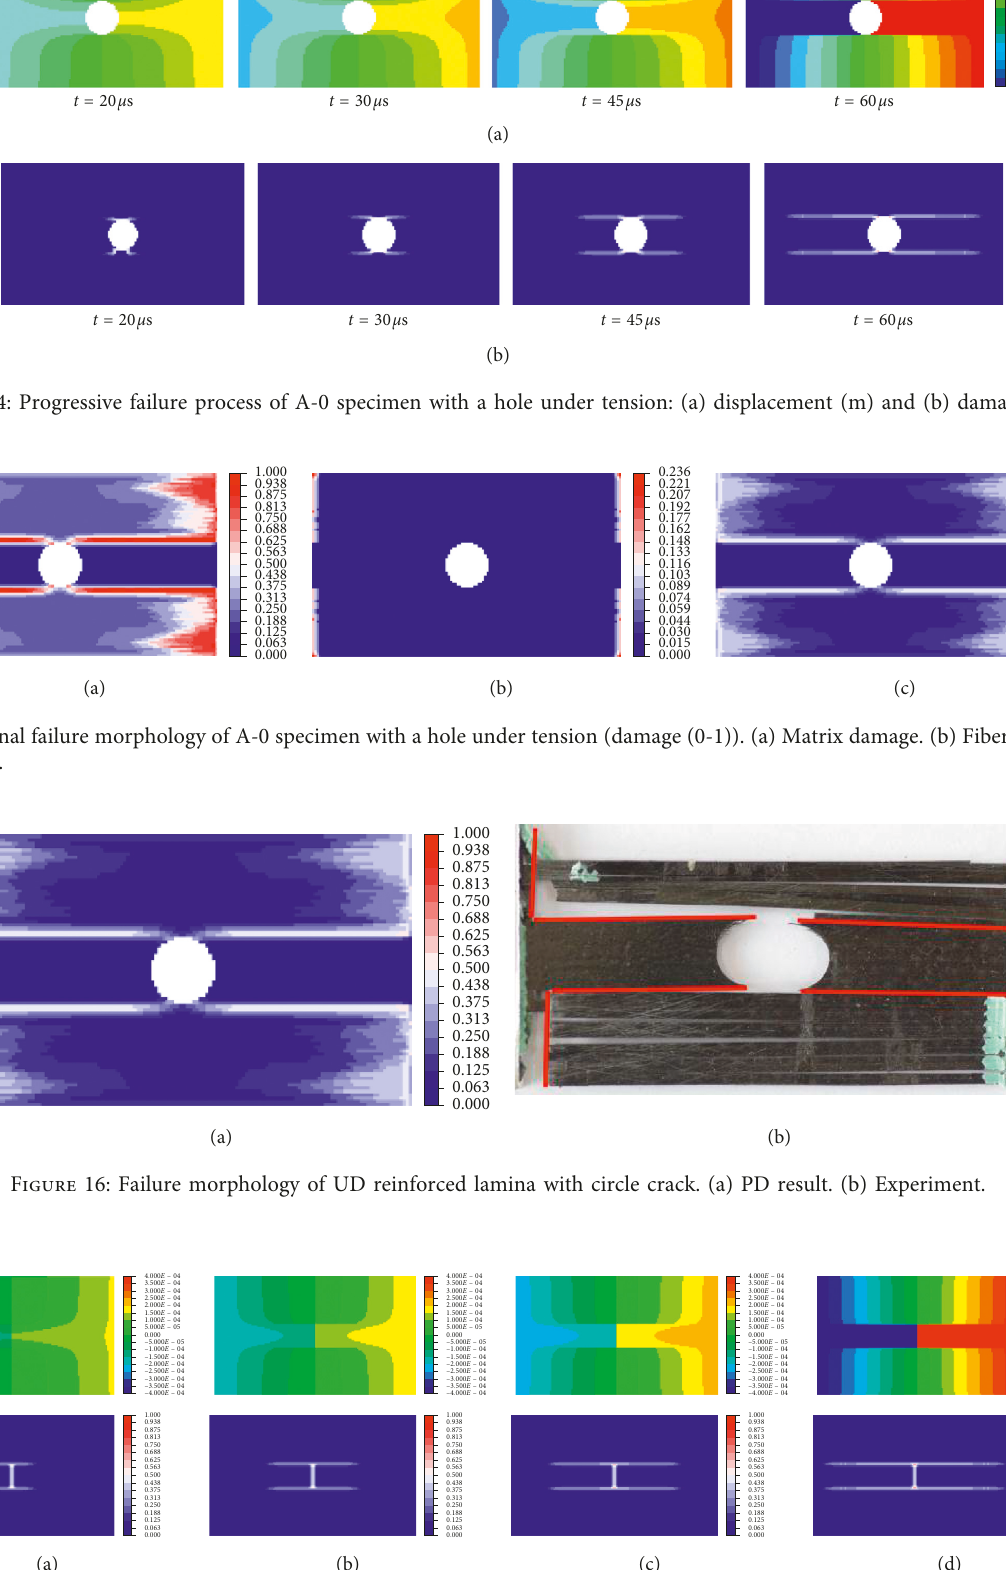
30 μ s. (b) t 50 μ s. (c) t 70 μ s. (d) t 100 μ (cid:27) (cid:27) (cid:27) (cid:27)